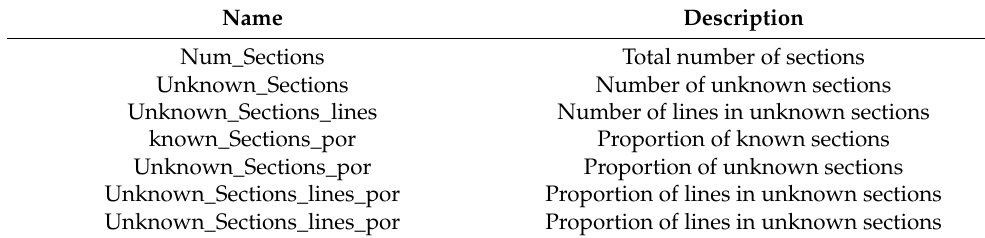
Table 2. List of features in the section category.